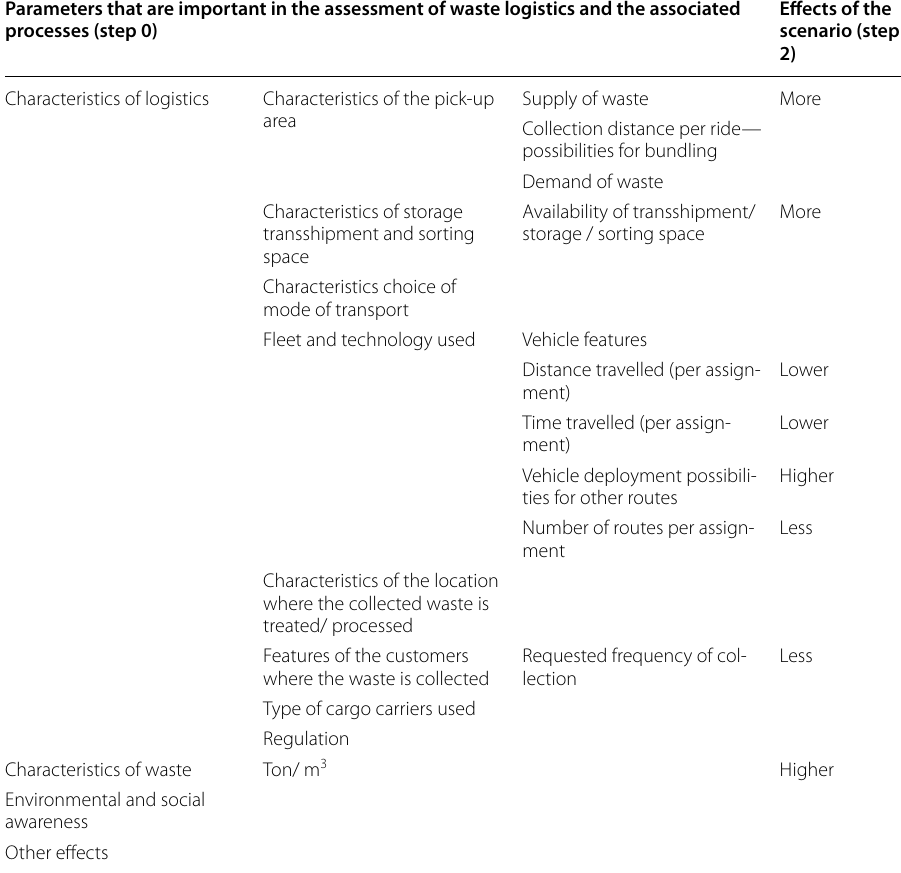
Table 5 Results step 3 case 2 (Waste compactor)